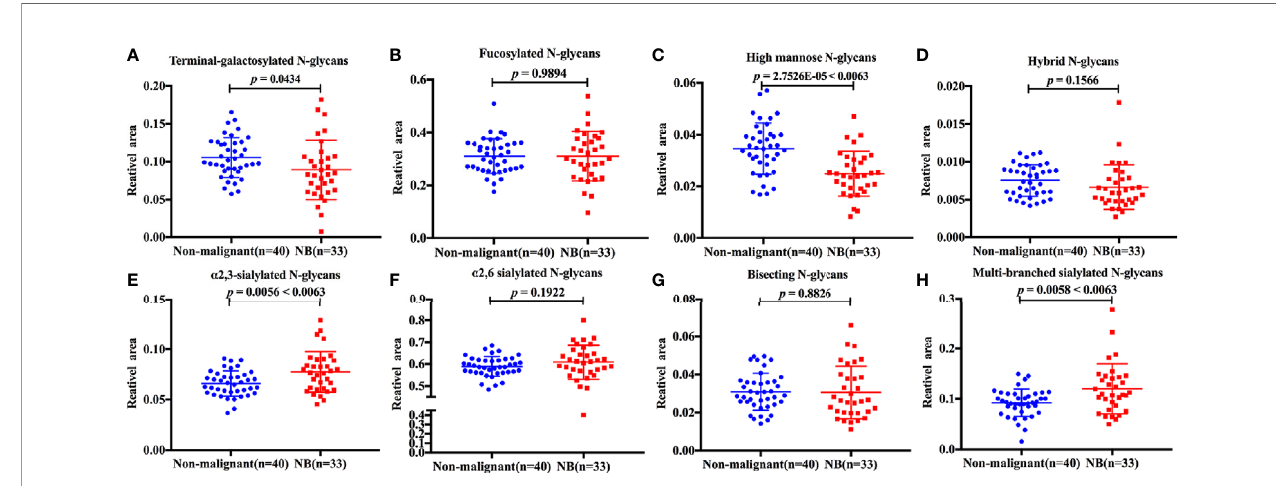
FIGURE 2 | The relative abundance of eight glyco-subclasses in NB patients and non-malignant controls. The N-glycans were grouped according to their structural characteristics. (A) Terminal-galactosylated N-glycans; (B) Fucosylated N-glycans; (C) High mannose N-glycans; (D) Hybrid N-glycans; (E) a 2,3-sialylated N-glycans;